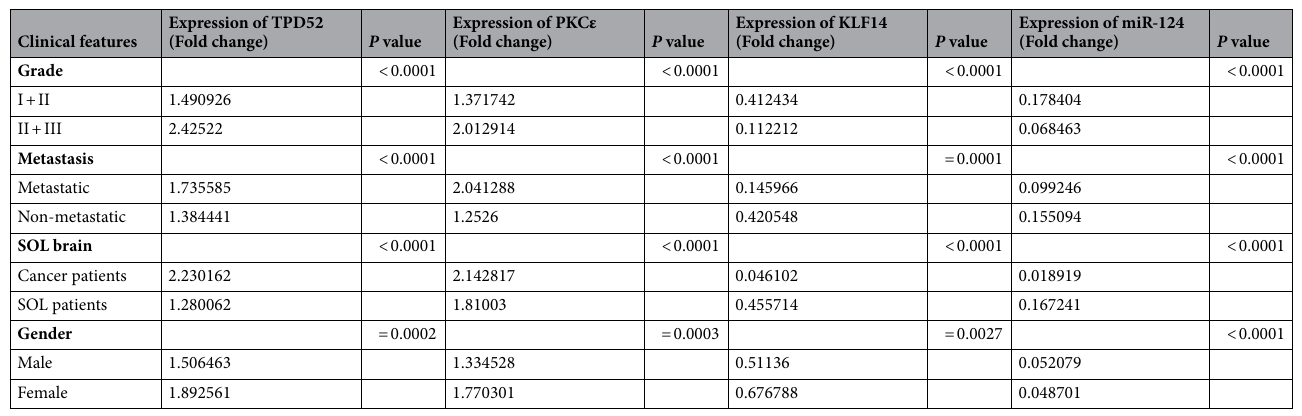
Table 3. Expression of TPD52, PKC epsilon, KLF14 and miR-124 across the clinical features in brain tumors. The table shows the fold change and P